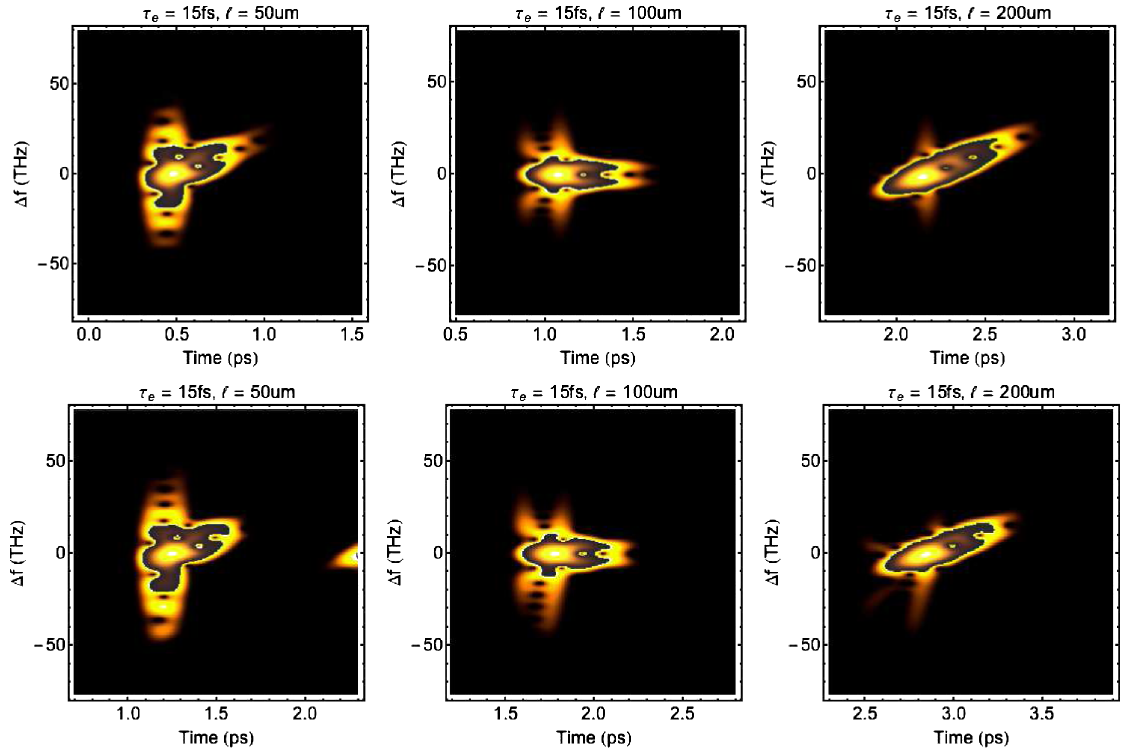
FIG. 7. Comparison between numerical results (top) and results from TURBOWAVE